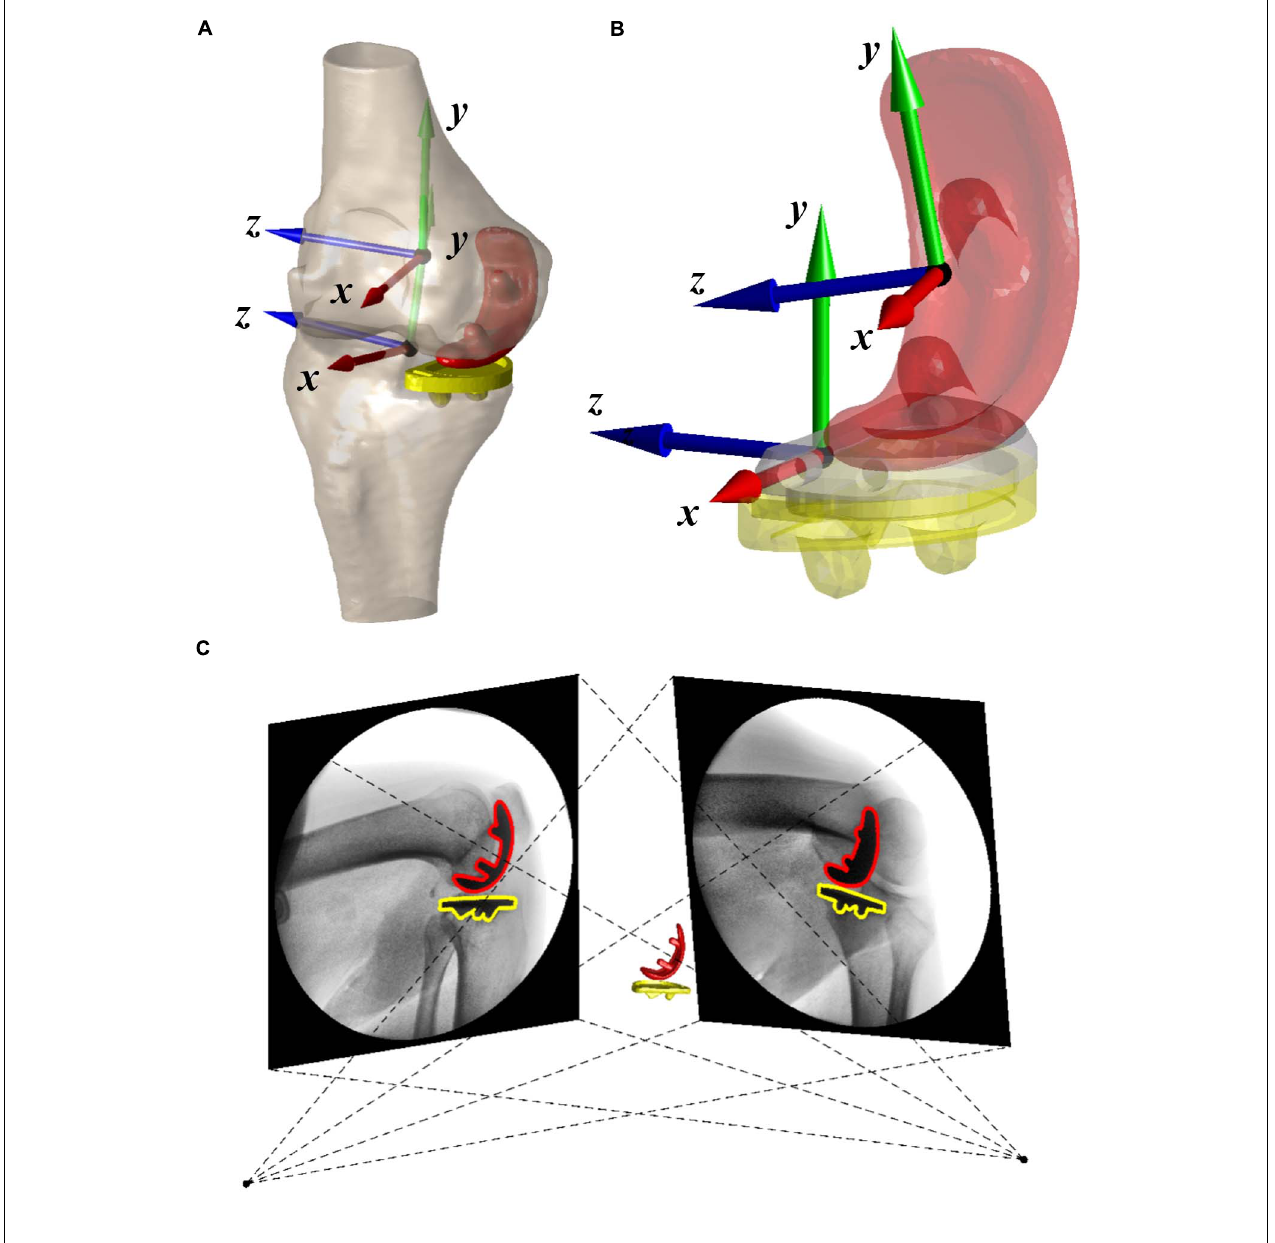
FIGURE 1 | (A) Three-dimensional surface models of the operated knee with coordinate systems and fixed-bearing unicompartmental knee arthroplasty (UKA). (B) The coordinate systems of UKA components. (C) Virtual environment of dual fluoroscopic imaging system (DFIS) was shown. The positions of red and yellow UKA components were adjusted until it matched the projection of 3D computer-aided design (CAD) models with outlines in two fluoroscopic images.